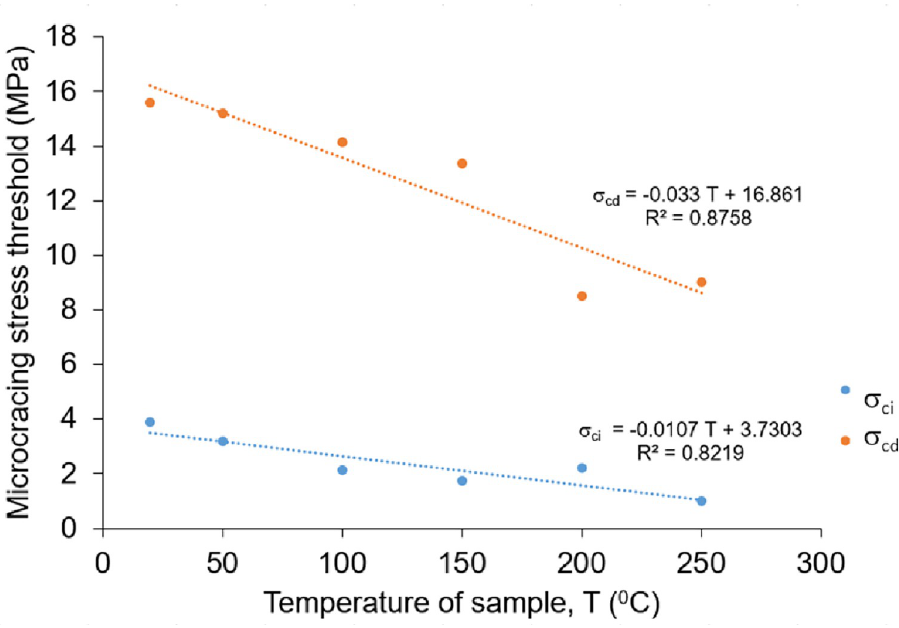
Fig 13. Microcracking stress thresholds (F073 ci , F073 cd ) versus temperatures of samples.